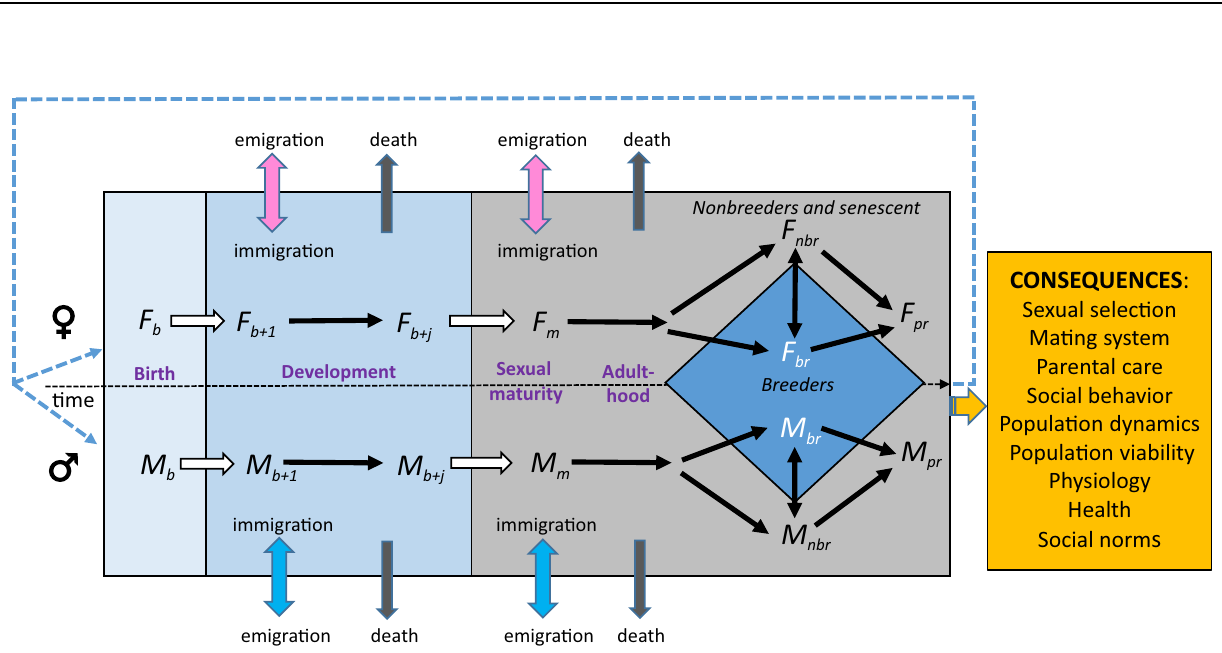
Fig. 1 Sex ratios at various life stages and their consequences. Males ( M ) and females ( F ) fl ow through stages from birth ( b ) through development into juveniles (or subadults) for up to j time steps, maturation ( m ), and adulthood. Adults include newly mature individuals and individuals who reached sexual maturity at an earlier time. Adults are classi fi ed as breeders ( br ), nonbreeders ( nbr ) that are capable of breeding but at present are not reproductively active, and post-reproductive individuals ( pr ) that are senescent. Transitions between stages are shown with white arrows and within stages with black arrows. The number of females and males, respectively, are depicted at birth ( F b and M b ), one ( F b + 1 and M b + 1 ) and j time steps later ( F b + j and M b + j ), at maturation ( F m and M m ), breeding ( F br and M br ), non-breeding ( F nbr and M nbr ) and post-reproduction ( F pr and M pr ). Different sex ratios emerge from various combination of the sexes at different stages: (1) Birth sex ratio = M b / ( F b + M b ); (2) Juvenile sex ratio = ( M b + 1 + M b + j ) / ( F b + 1 + F b + j + M b + 1 + M b + j ); (3) Maturation sex ratio (MSR) = M m / ( F m + M m ); and (4) Adult sex ratio (ASR) = ( M m + M nb + M br + M pr ) / ( F m + F nb + F br + F pr + M m + M nb + M br + M pr ). Consequences of sex ratios discussed in the paper are various life stages including (i) pre-birth/birth, (ii) juvenility and